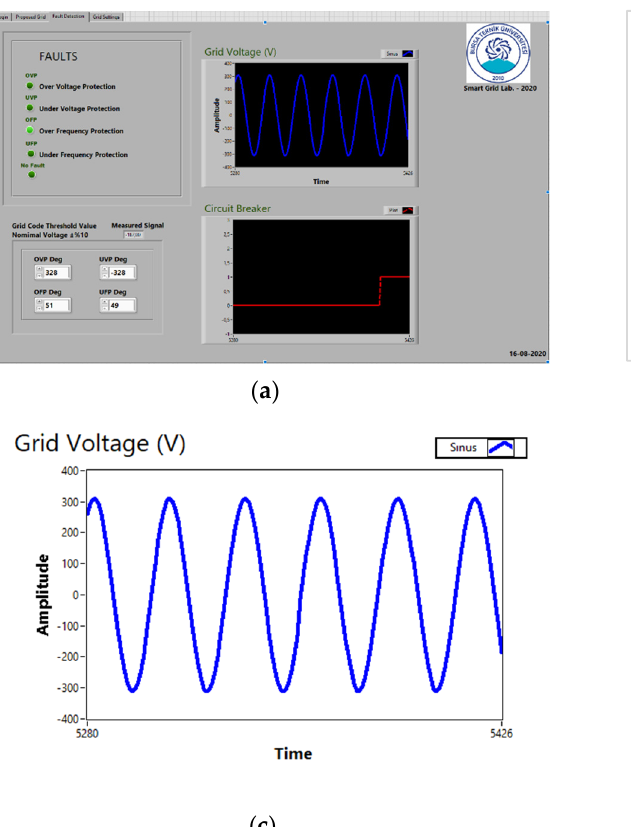
Figure 6. ( a ) UVP condition in DGPS; ( b ) status of grid voltage and CB.